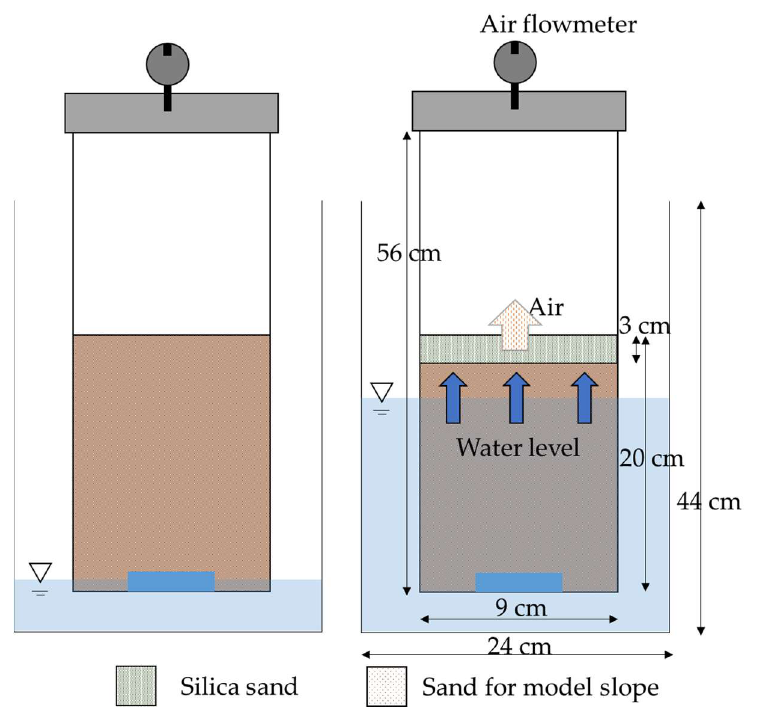
Figure 3. Overview of equipment used to assess how silica sand entraps air. We prepared a vertical acrylic cylinder to construct the soil layer, as shown above. In this case we layered 3 cm of silica sand on top of the normal sand, and in the other case we used only sand. We increased the water level from the bottom of the cylinder and measured the volume of air flow using an air flowmeter.